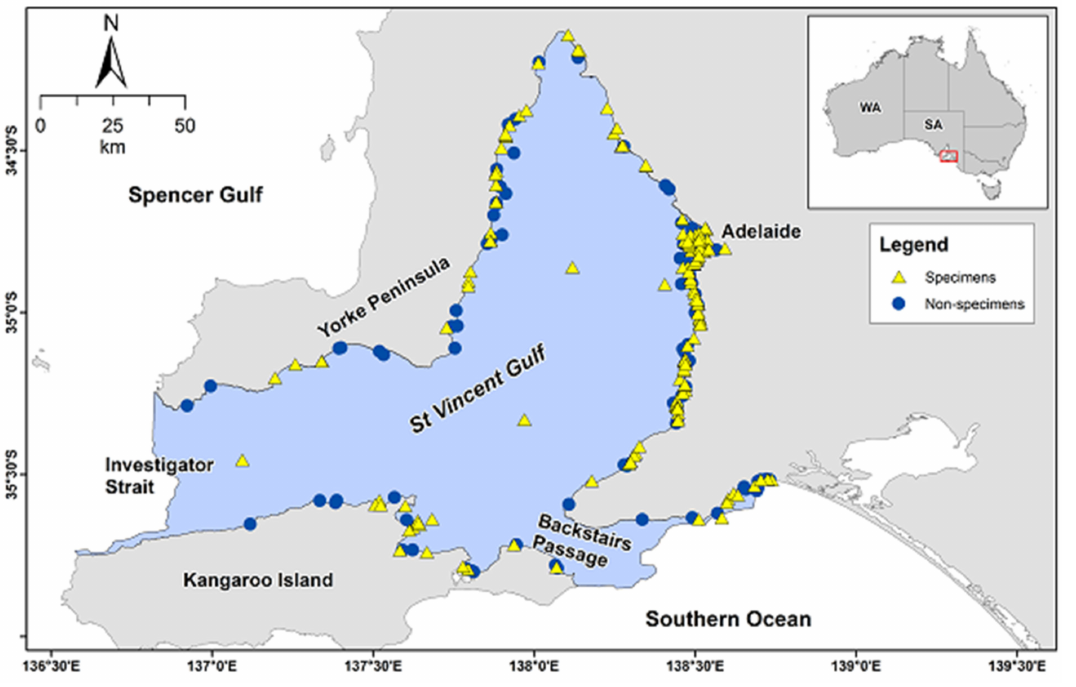
Figure 1. Map showing the locations of specimen and non-specimen records used in the study on St Vincent Gulf Bioregion cetaceans during 2009–2020. The blue shaded area is the bioregion. (See Section 2.2 for definitions of ‘specimen’ and